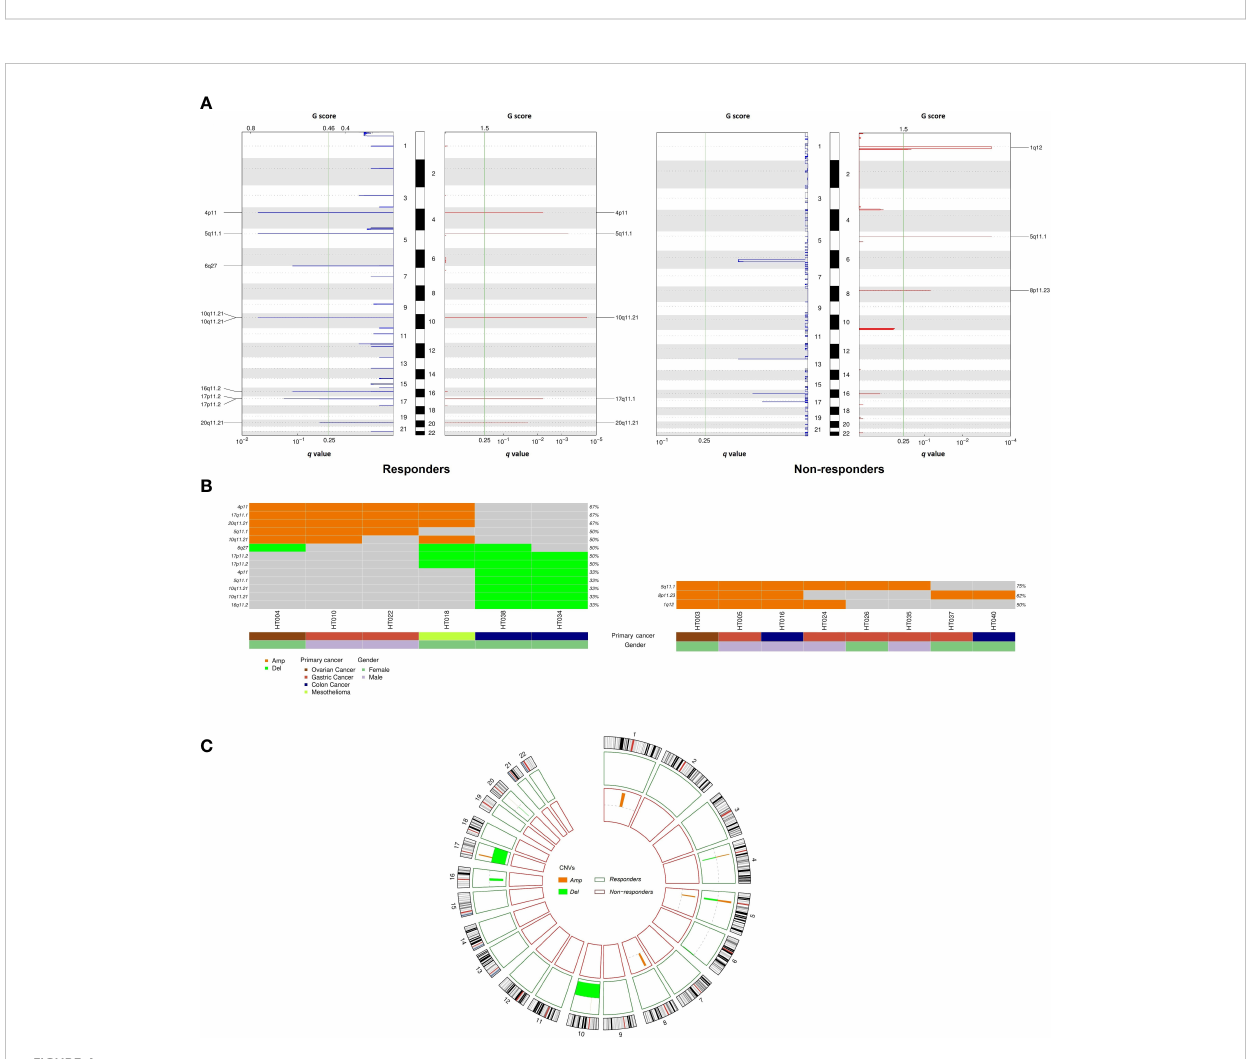
FIGURE 4 Comparison of copy number variation between responders and non-responders. (A) Ampli fi cations and deletion peaks identi fi ed by GISTIC2.0 (q < 0.25); (B) Recurrent focal ampli fi cation and deletion regions detected for each tumor; (C) Circos plot summarizing copy number variation distribution in the two cohorts.